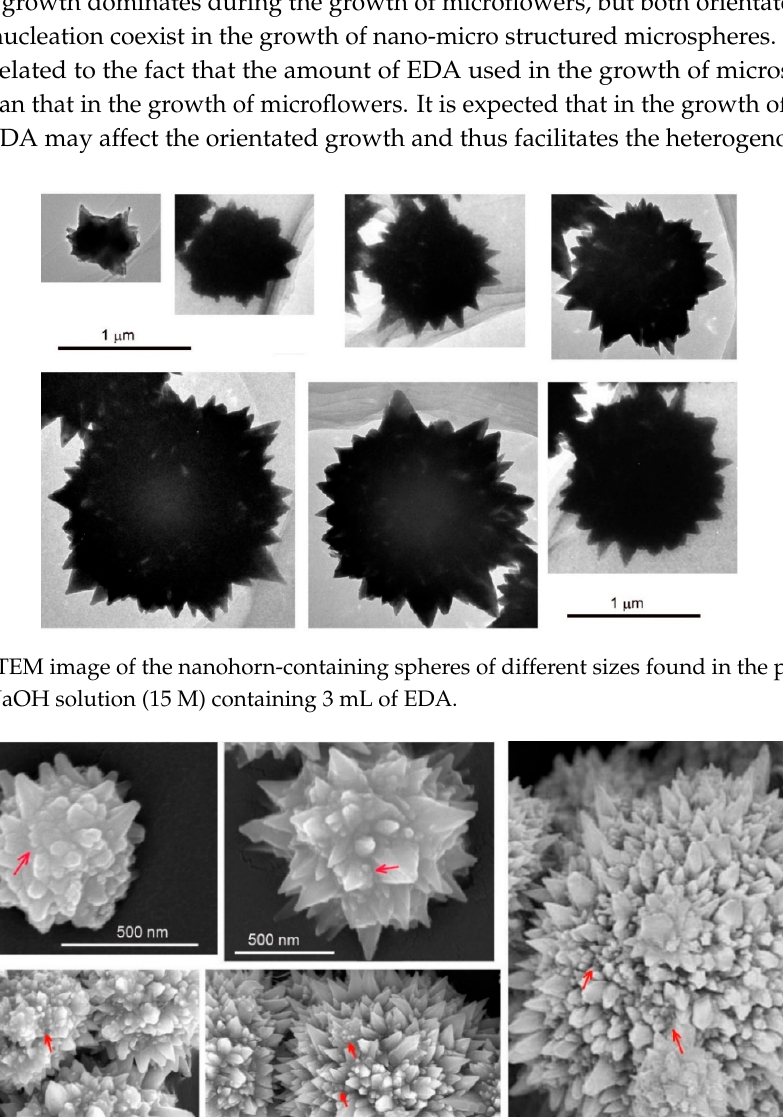
Figure 12. A scheme for the growth mechanism of Ni nano-micro structures: ( a ) Ni nanocrystals; ( b ) aggregation of Ni nanocrystals; ( c ) small-sized sphere with nanohorns and new nuclei; ( d ) middle- sized microspheres with nanohorns and new nuclei; ( e ) big-sized microspheres with nanohorns and new nuclei; ( f ) chain-like structure; ( g ) small-sized particle with nanohorns; ( h ) middle-sized microflower with nanohorns; and ( i ) big-sized microflower with nanohorns. New nuclei produced by heterogenous nucleation are indicated by blue arrows. 4. Conclusions In summary, we have presented a study on the EDA-mediated growth of Ni nano-micro structures under strong alkaline conditions. Both EDA and NaOH play an important role in the reduction of Ni (II) to Ni, and Ni microflowers or microspheres assembled from nanosized horns can be grown in the presence of EDA of different amounts. The size of the nano-micro structured Ni microspheres depends on the NaOH concentration, and long microsphere chains form when the